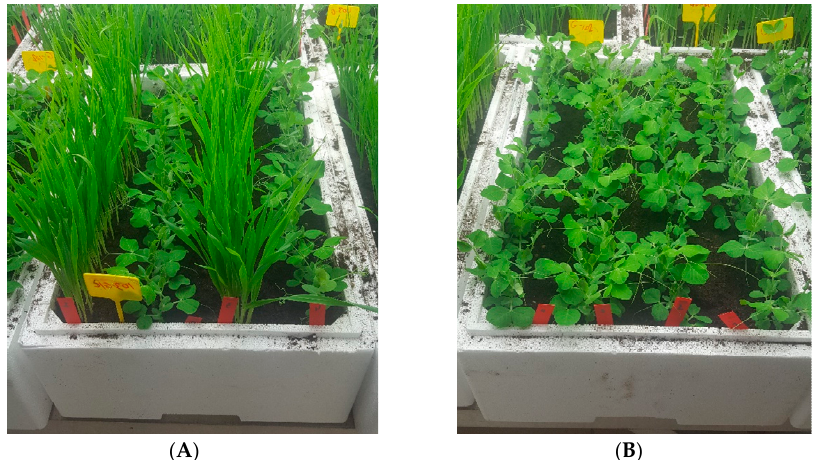
Figure 3. Pea monocrop ( A ) and pea intercropped with barley ( B ) in the experiment under controlled